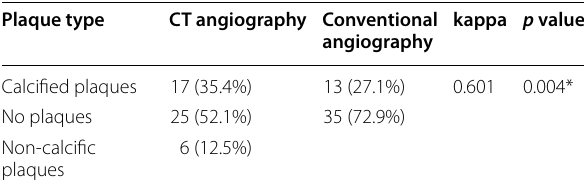
Table 3 Analysis of the plaque types in the conventional and CT angiography